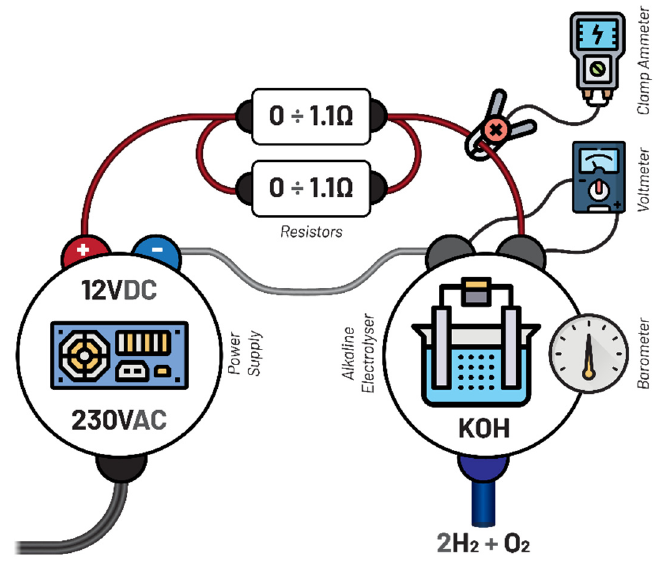
Figure 2. Setup for measuring electrolyzer characteristics.